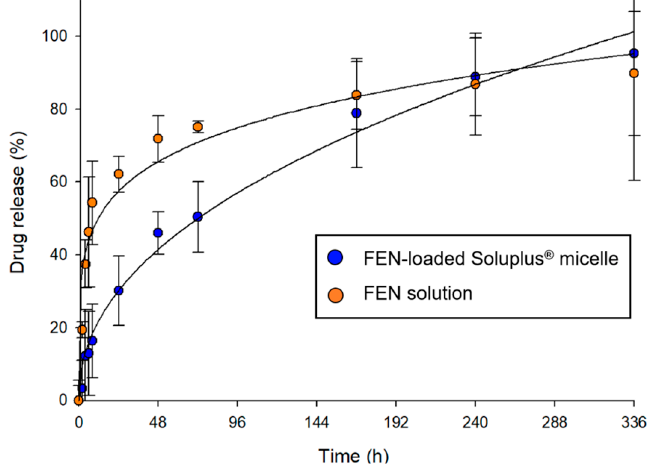
Figure 3. In vitro release profile of fenbendazole (FEN) from Soluplus ® micelles and 25% Cremophor EL ® /EtOH solution at 37 °C.